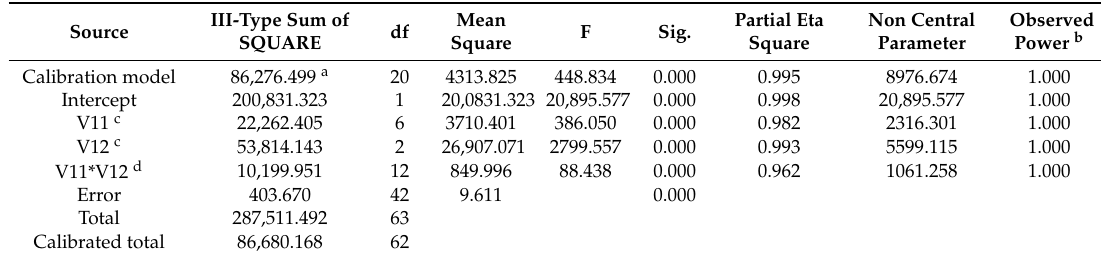
Table 3. Significance analysis of different processes comparation data.